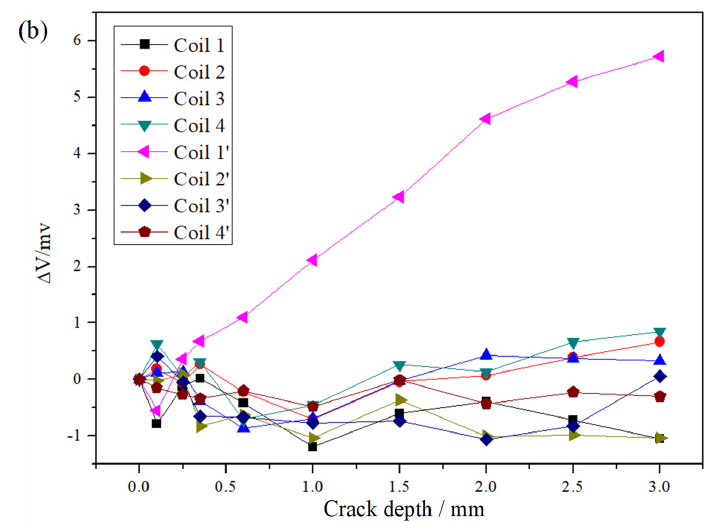
Figure 13. The experimental result of two-dimensional coil array sensing film. ( a ) The crack at the site of Coil 1; ( b ) The crack at the site of Coil